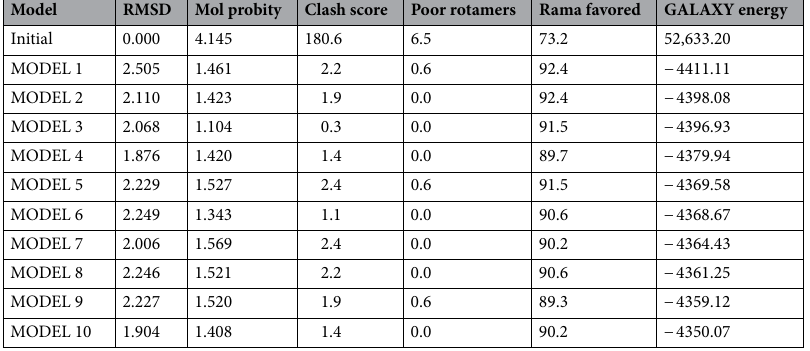
Table 1. Information about structural properties of the ten models generated after refining the structure of the crude multi-epitope